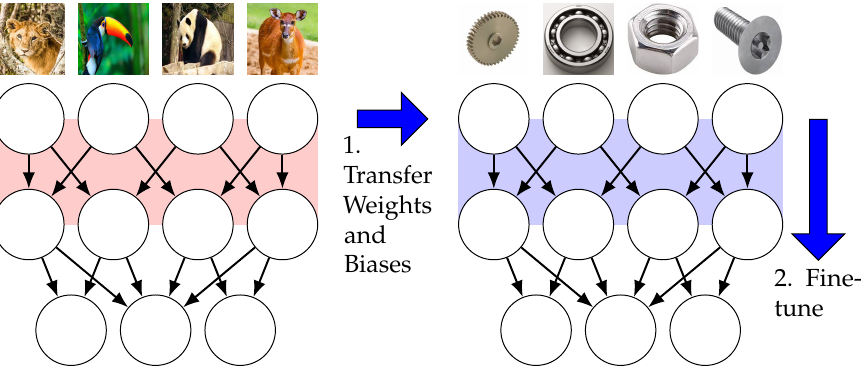
Figure 10. In parameter-based TL, the model is firstly trained using relevant datasets (left) and the layers of corresponding model parameters (in red dashed box) are transferred to a target model (in green dashed box) followed by fine-tuning.